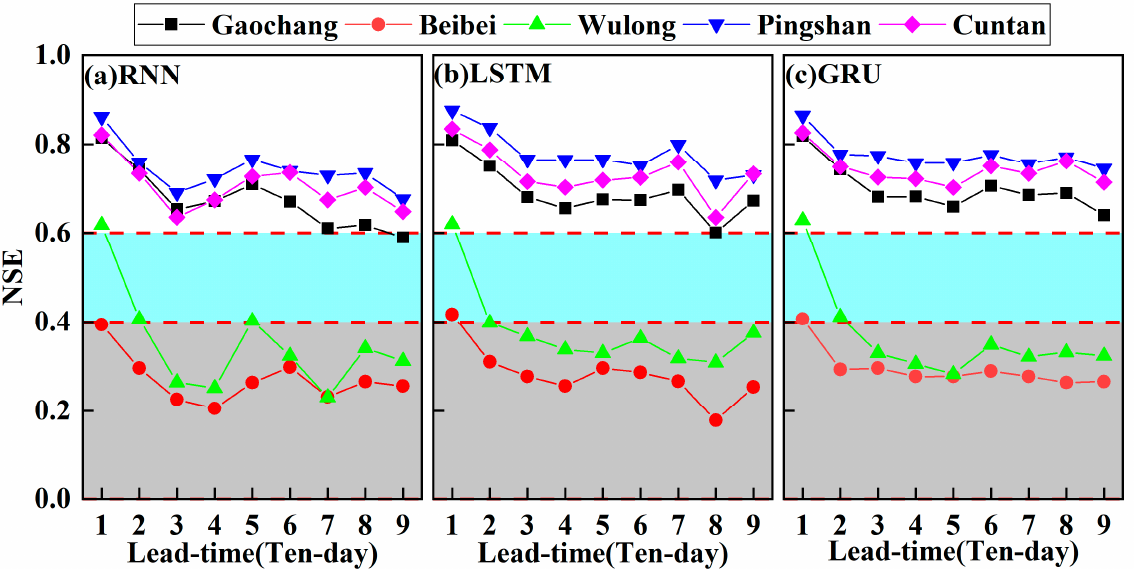
Figure 9. The performance of runoff prediction at the lead times of 1–9 ten days by ( a ) RNN, ( b ) LSTM, and ( c ) GRU models with optimal time lags.